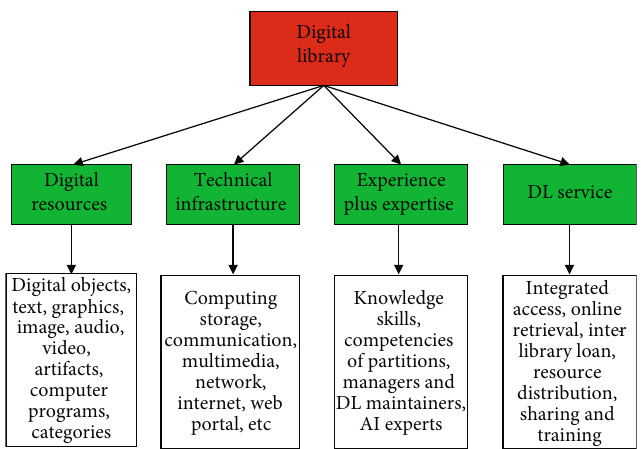
Figure 2: An overview of our designed data mining-based digital library